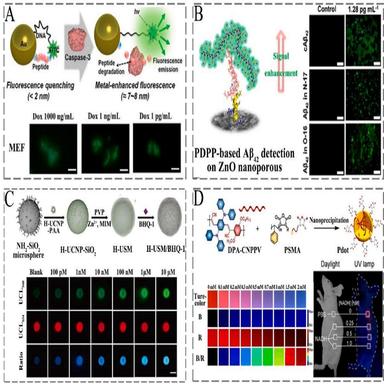
(A) Fluorescence images of isothiocyanate-labeled AuNP-based fluorescence nanoprobe for the detection of Caspase-3 in the MCF-7 cells from ref.. Copyright 2020 American Chemical Society. (B) Fluorescein isothiocyanate-labeled peptide polymer for the detection of Aβ42 in CSF on a ZnO nanoporous platform from ref.)]. Copyright 2019 American Chemical Society. (C) Upconversion luminescence images of highly doped UCNPs--SiO2@ZIF-8/BHQ-1 microspheres for Aβ42O from ref. (#